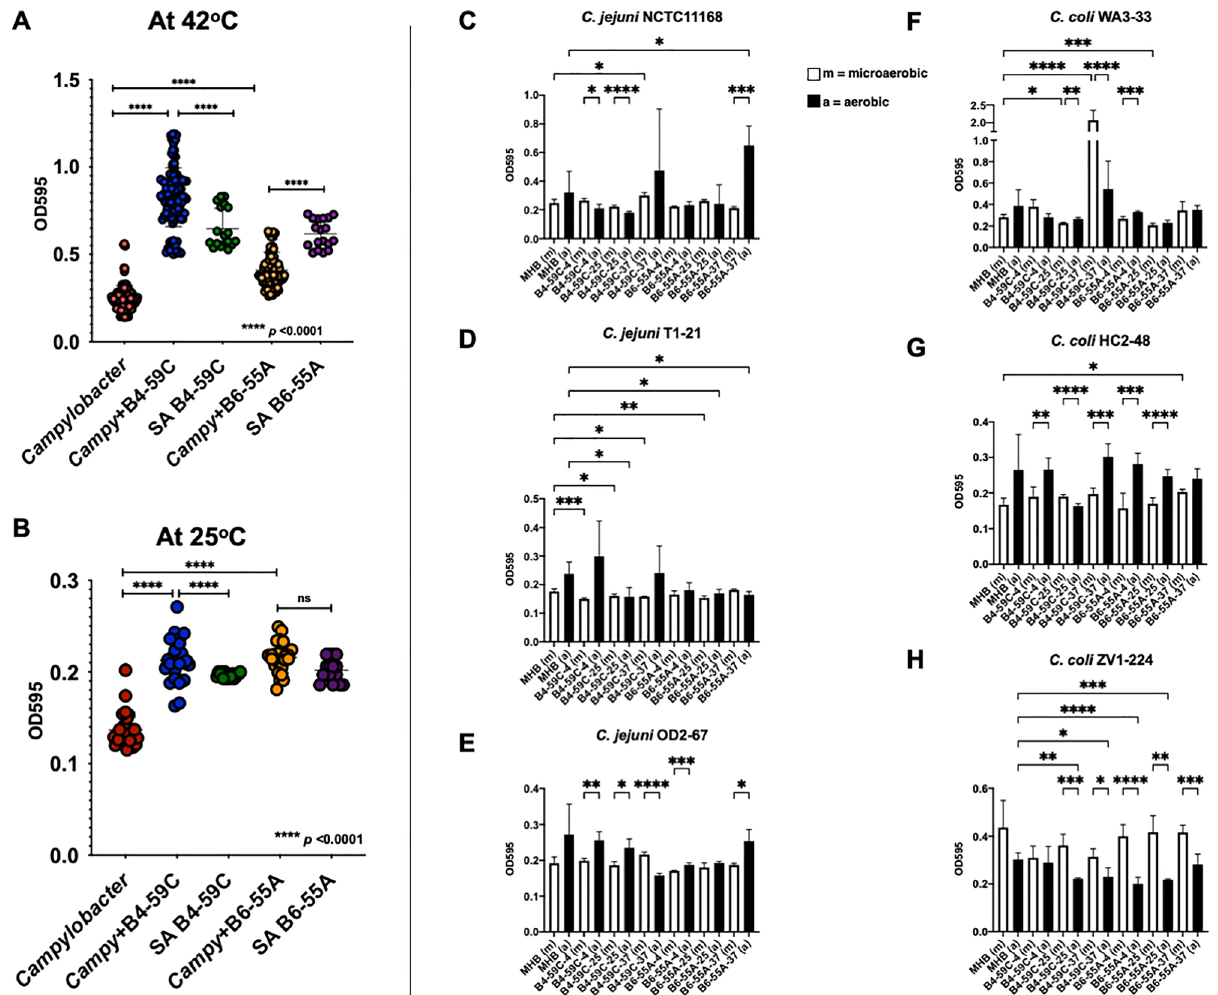
Figure 3. Biofilms produced by Campylobacter in mono and mixed cultures containing S. aureus strains or cell-free extracts. Biofilms adhering to polystyrene plates were measured at A 595 . ( A , B ) Biofilms formed by Campylobacter strains (all C. jejuni/coli strains) at 25 °C and 42 °C in mono and mixed cultures containing S. aureus strains B4-59C and B6-55A in aerobic condition. The production of biofilms by S. aureus B4-59C and B6-55A monocultures are included. ( C – H ) Biofilm formation of Campylobacter strains at 42 °C in cell-free filtrates from S. aureus media in microaerobic (m) and aerobic environment (a). Each bar in figures represents the mean value with SD error bar. Two-way ANOVA (Tukey multiple comparison tests) and Brown-Forsythe and Welch ANOVA tests (One-way ANOVA) were conducted in GraphPad Prism 9: * p < 0.05, ** p < 0.01, *** p < 0.001, **** p < strains in retail meat products originated from the respective animal 3,4,22,34 . Although the virulence of the S. aureus strains used in this study has not been tested, multiple virulence factors were identified in their genomes, including the gene encoding toxic shock syndrome 34 . Prolonged survival of the six Campylobacter strains when cultivated with S. aureus cells or cell-free exudates indicates that S. aureus improves the survival of Campylobacter at lower temperatures. Previous studies regarding the transcriptional landscape of Campylobacter during survival at low temperature indicated that genes involved in quorum sensing and the acquisition of cryoprotectant molecules were differentially expressed 40–42 . Further- more, Campylobacter was shown to utilize exogenous siderophores produced by other microorganisms 43,44 ; these are used for iron acquisition during growth and survival and might also contribute to virulence. Our results showing improved survival of Campylobacter in S. aureus cell-free exudates indicates that metabolites produced by S. aureus improve the survival of Campylobacter . It is also important to note that Campylobacter cells undergo a transition to the VBNC stage during cold stress and remain viable for prolonged periods of time 14 . Hence, the presence of S. aureus cells or cell-free extracts might provide a protective environment for Campylobacter and facilitate viability for prolonged periods at lower temperatures. In this study, we counted culturable Campylobacter cells after incubation at 4 °C; however, this study did not address the impact of S. aureus on the VBNC condition of Campylobacte r cells. A previous report documented the detrimental effects of pre-established, organismal biofilms from poultry on the survival of C. jejuni at 10 °C 26 . Organisms identified in biofilms from poultry